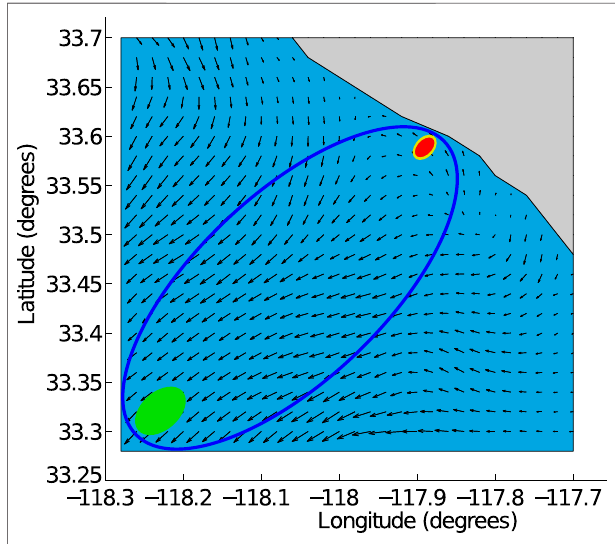
FIGURE4| Theblueellipticalgoal-constrainedbeliefspace R * ( b 0 , b g ) is given as prior knowledge for the green goal belief state b g from the red initial belief state b 0 of the